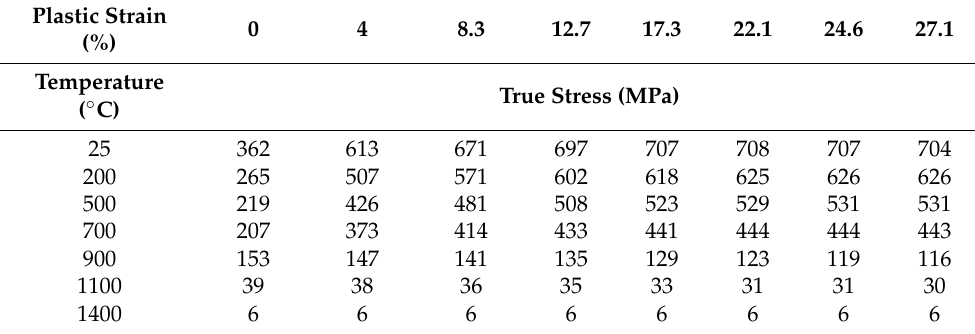
Table 11. Flow stress of 316L at different